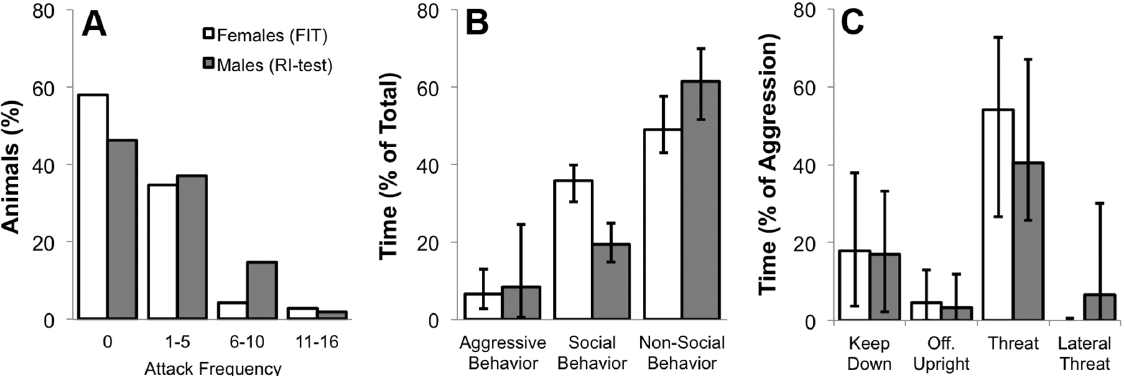
Figure 2. Behavioral profile of adult (10–11 week old) virgin female NAB residents (n=69) during their first 10-min female intruder test (FIT), and adult (16–22 week old) male NAB residents (n=108) during their first 10-min resident-intruder test (RI-test). A: attack frequency distribution; B: aggressive, social and non-social behavior as percentage of total behavior; C: different types of offensive behavior as percentage of total aggressive behavior. Data are medians and quartiles. A statistical comparison of the sexes was not performed.